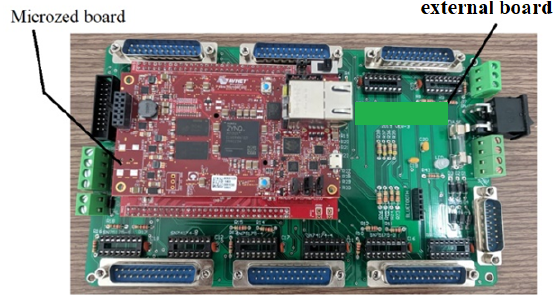
Figure 2. Hardware